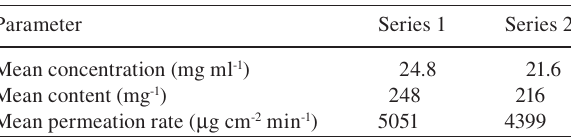
Table 6 The calculated oil content and permeation rate for two measurement series on sample